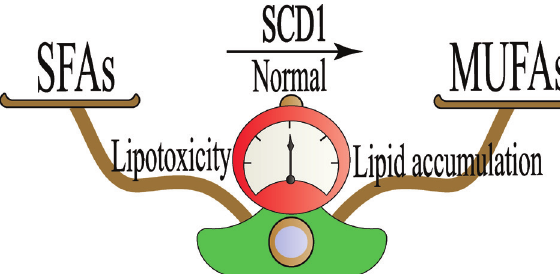
Figure 3. Stearoyl-coenzyme A desaturase 1 (SCD1) activity is associated with normal liver function. The schematic balance represents that the equilibrium between saturated fatty acids (SFAs) and monounsaturated fatty acids (MUFAs) is important in the physiological state. The loss of this equilibrium is due to overactivity and underactivity of SCD1 in hepatic lipid accumulation and lipotoxicity,